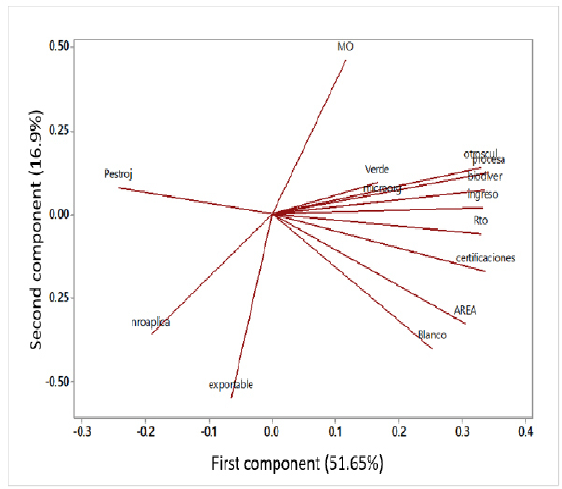
Figure 3. Variables analysed by principal component analysis of the asparagus farms.